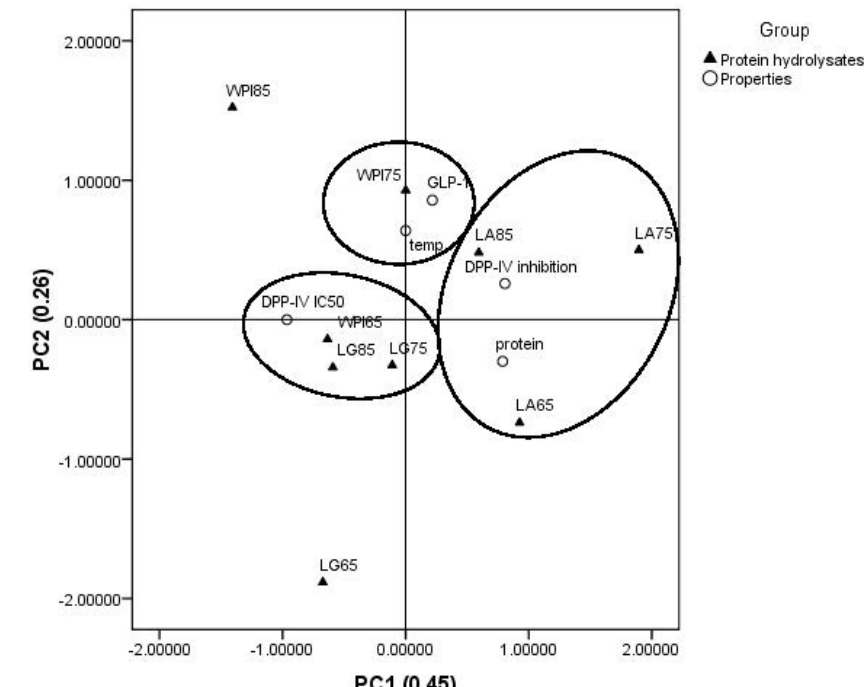
Figure 4. Bi-plot for the protein hydrolysates and their properties from principal component analy- sis (PCA). WPI, LG, and LA denote whey protein isolate, β -lactoglobulin, and α -lactalbumin solu- tions, respectively. The number after the abbreviated protein solutions indicate the temperature (°C) of the heat treatment process.